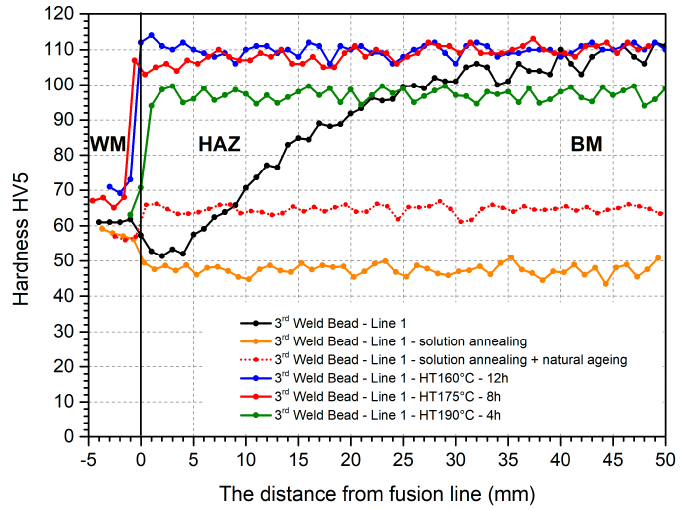
Figure 15. Measured hardness values in three-pass weld in the zone of line 1 after welding with preheating temperature of 150 °C and after different types of heat treatment. After application of the heat treatment to the welded joint, the structural changes in the HAZ were again assessed. Figure 16a shows the microstructure of the HAZ after welding three beads with a preheating temperature of 75 °C, solution annealing at 530 °C for 1 h, water cooling and subsequent artificial aging at 160 °C for 12 h. As in Figure 9a, the zone is located 3 mm from the bottom edge of the sample (line 1) and 4 mm from the fusion line. Figure 16b shows the microstructure of the HAZ after welding three beads with a preheating temperature of 150 °C in the same location.